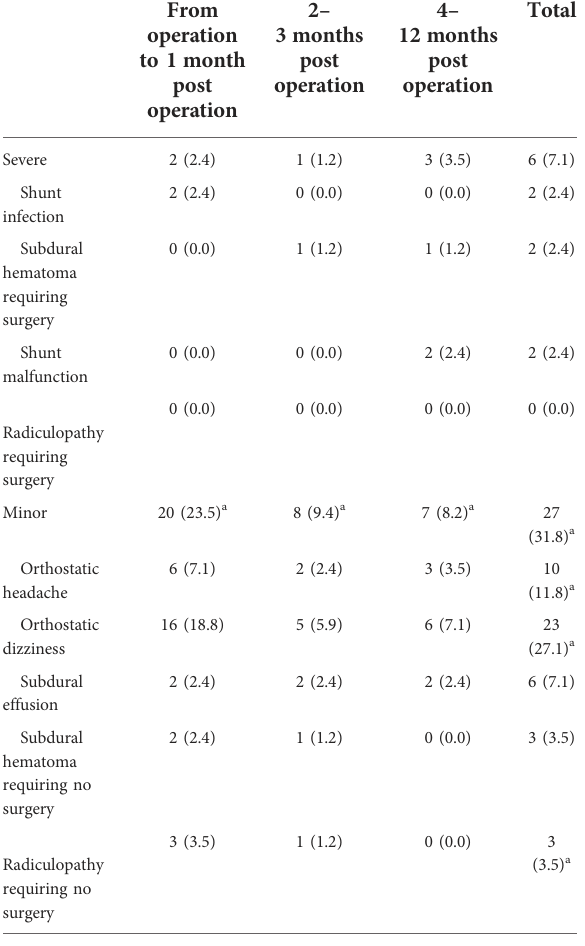
TABLE 6 Operation-related complications [ n